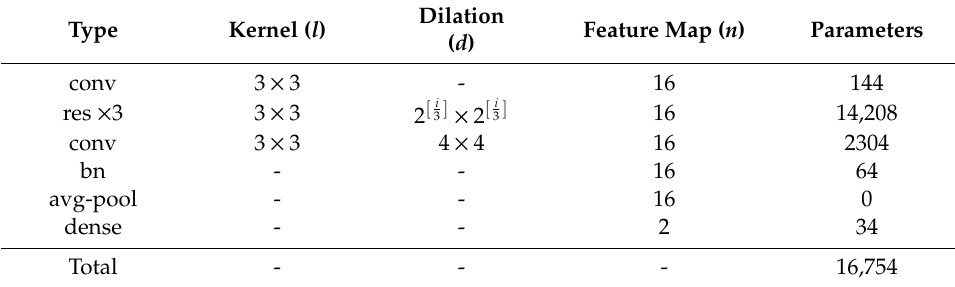
Table 6. Parameters used for the ResNet system.